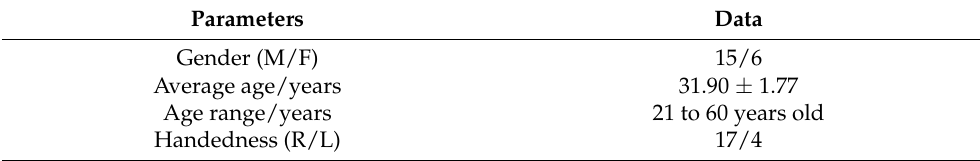
Table 1. Demographic